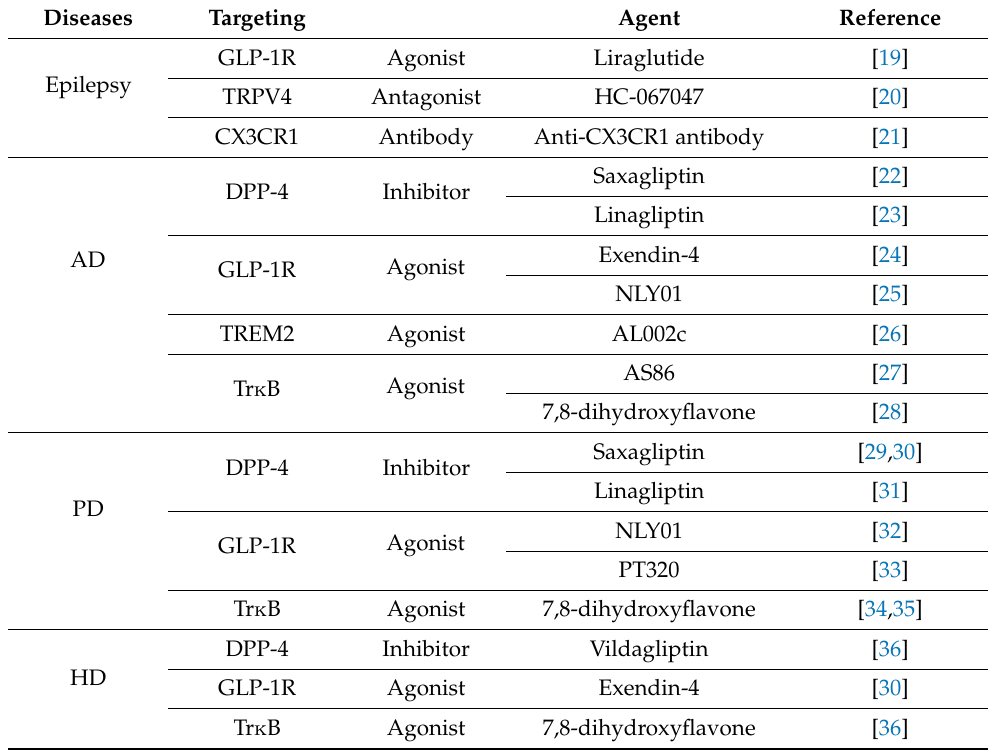
Table 1. Microglia-targeting for